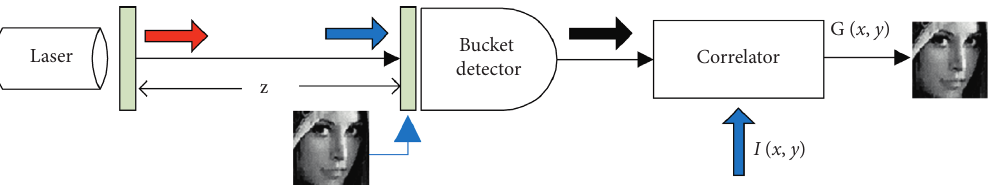
Figure 2: The basic theory of